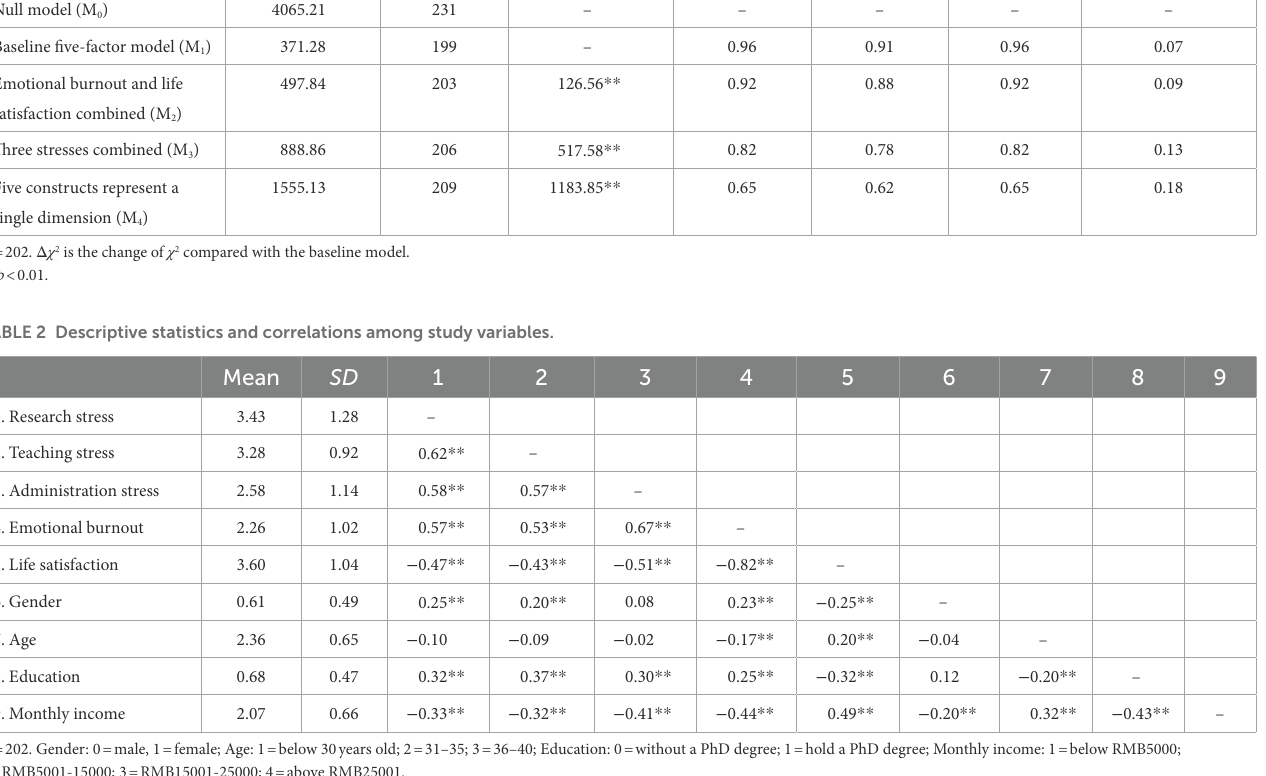
TABLE 1 Confirmatory factor analyses of measurement models. Model specifications